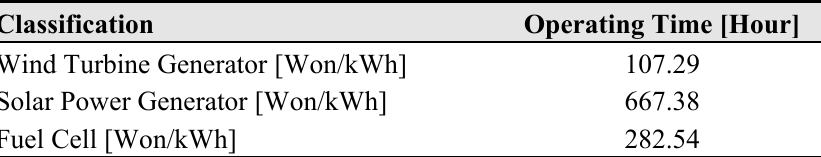
Table 6. The power rate of DG